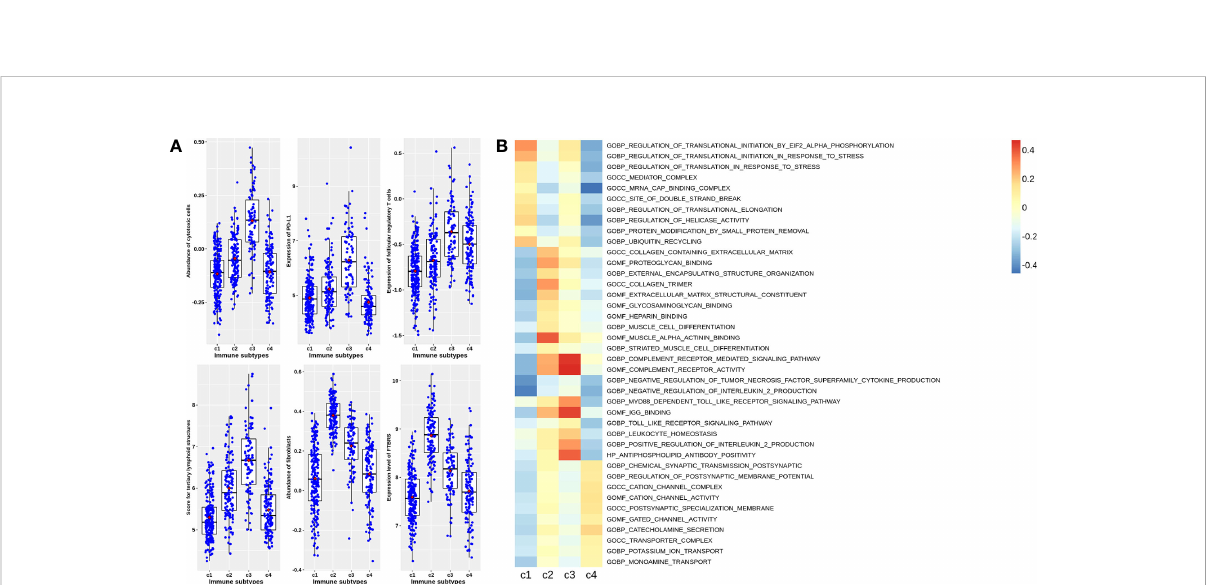
FIGURE 2 Characteristics of four immune subtypes in GSE39582. (A) Scatter plots overlapped with box plots illustrating differences in six major immune related scores among four immune subtypes. The red diamonds in each box indicate mean value. (B) Results from GSVA analysis showing ten major signi fi cantly enriched pathways in each immune